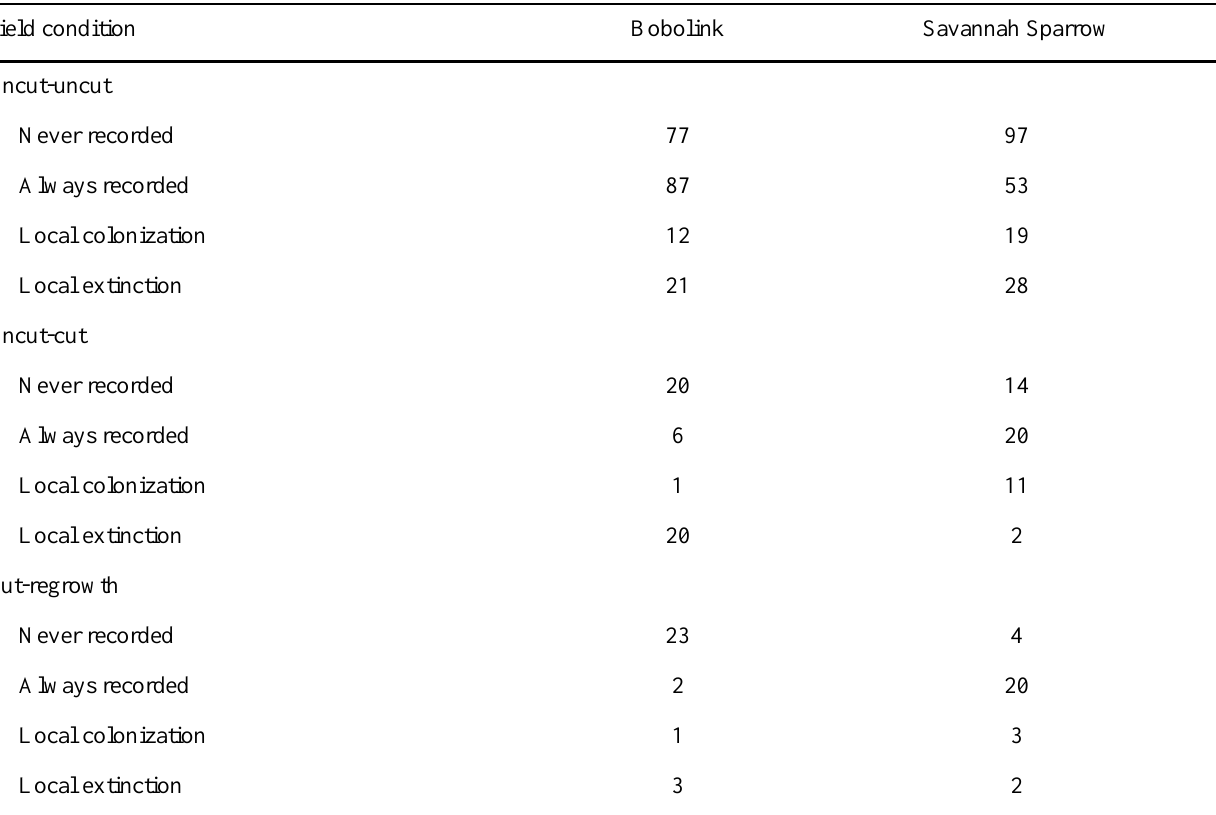
Table 6. Occupancy patterns of male Bobolinks and male Savannah Sparrows between visits based on changes in field conditions on agricultural fields in the Champlain Valley of Vermont and New York, May 21 to July 2, 2002. Each heading reflects a possible mowing history between successive sampling visits: never mowed (uncut-uncut), mowed between visits (uncut-cut) or allowed to regrow following earlier mowing (cut-regrowth). Counts reflect number of fields. Each field in the study is represented twice because each field had two opportunities to undergo change in mowing (i.e., between visits 1 and 2 and between visits 2 and